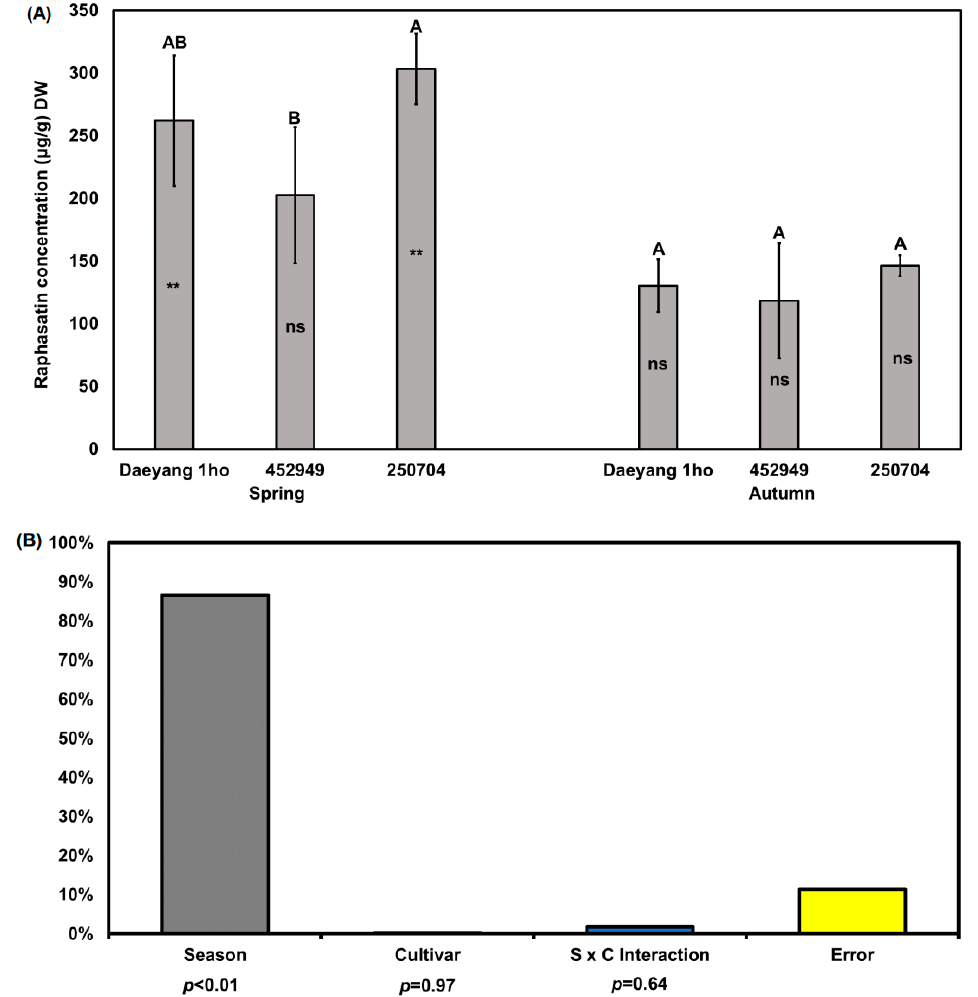
Figure 3. ( A ) Raphasatin concentrations in the roots of three different radish cultivars grown in spring and autumn 2020. Raphasatin concentration expressed as phenyl isothiocyanate equivalent concentration. Different capital letters above the error bars indicate significant differences among cultivars within the same season, according to Tukey’s HSD test ( p < 0.05). Asterisks (**) and ns inside the bars indicate non-significantly difference or significant differences between spring and autumn within the same cultivar according to an unpaired t -test ( p > 0.05, p < 0.01, respectively); ( B ) Two-way ANOVA for raphasatin concentrations in radish root among three different cultivars across two seasons. S × C indicates season and cultivar interaction. % in y axis of (B) indicates % of explained variation.